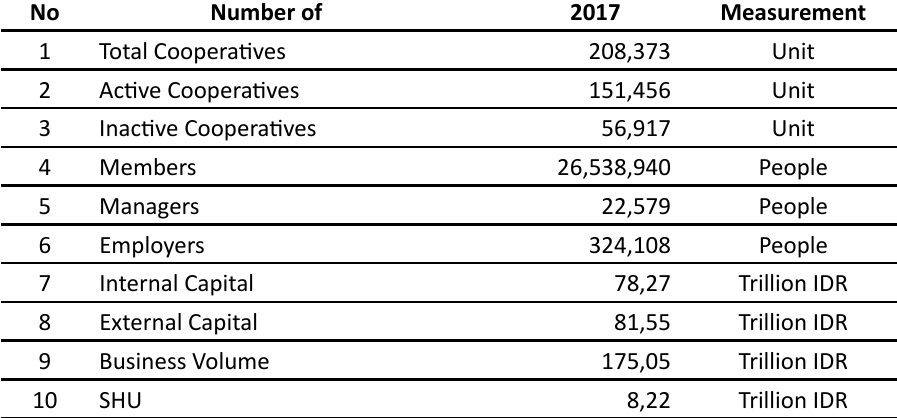
Table 1: National Cooperatives Performance in